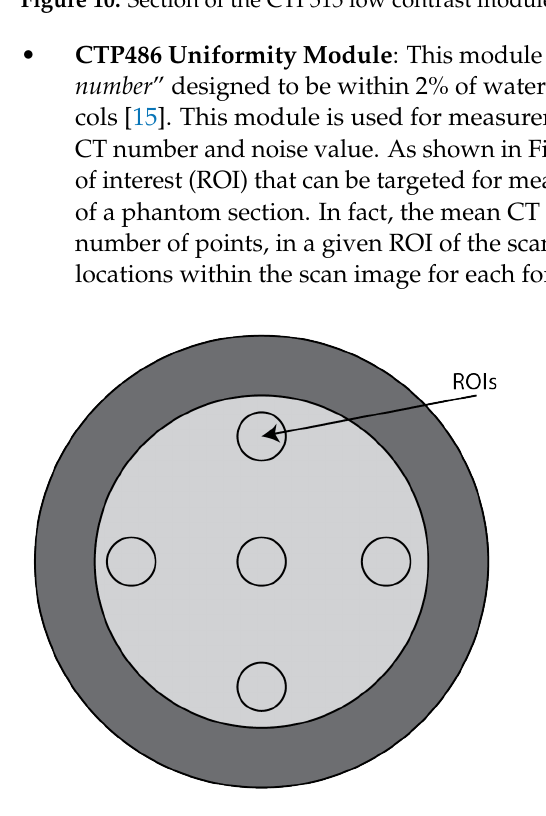
Figure 11. CTP486 uniformity